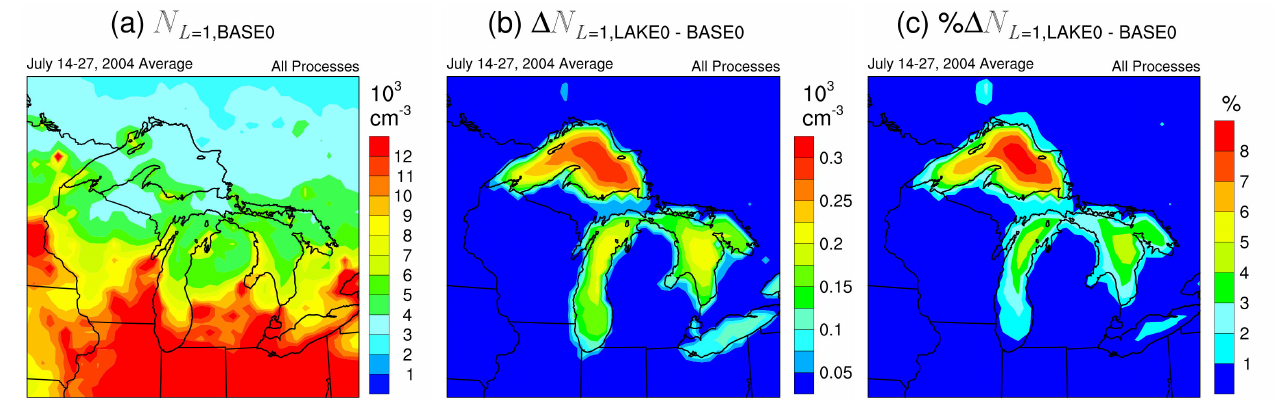
Fig. 8. Simulation results averaged over the 14–27 July 2004 two-week period with all aerosol dynamical processes included: (a) surface- layer aerosol number concentration (10 3 cm − 3 ) for the BASE0 case, (b) difference between LAKE0 and BASE0 cases, and (c) percent difference between LAKE0 and BASE0 cases.